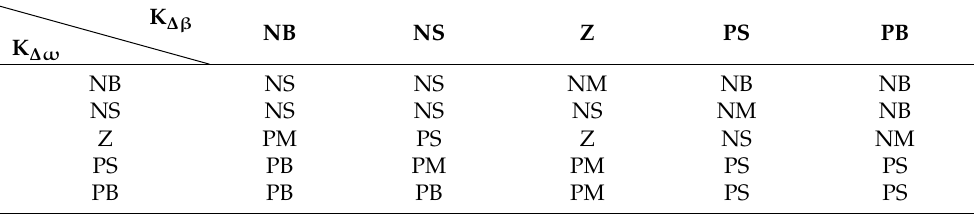
Figure 7. The vehicle anti-loss control strategy. Table 1. The fuzzy rules of vehicle anti-loss control strategy.